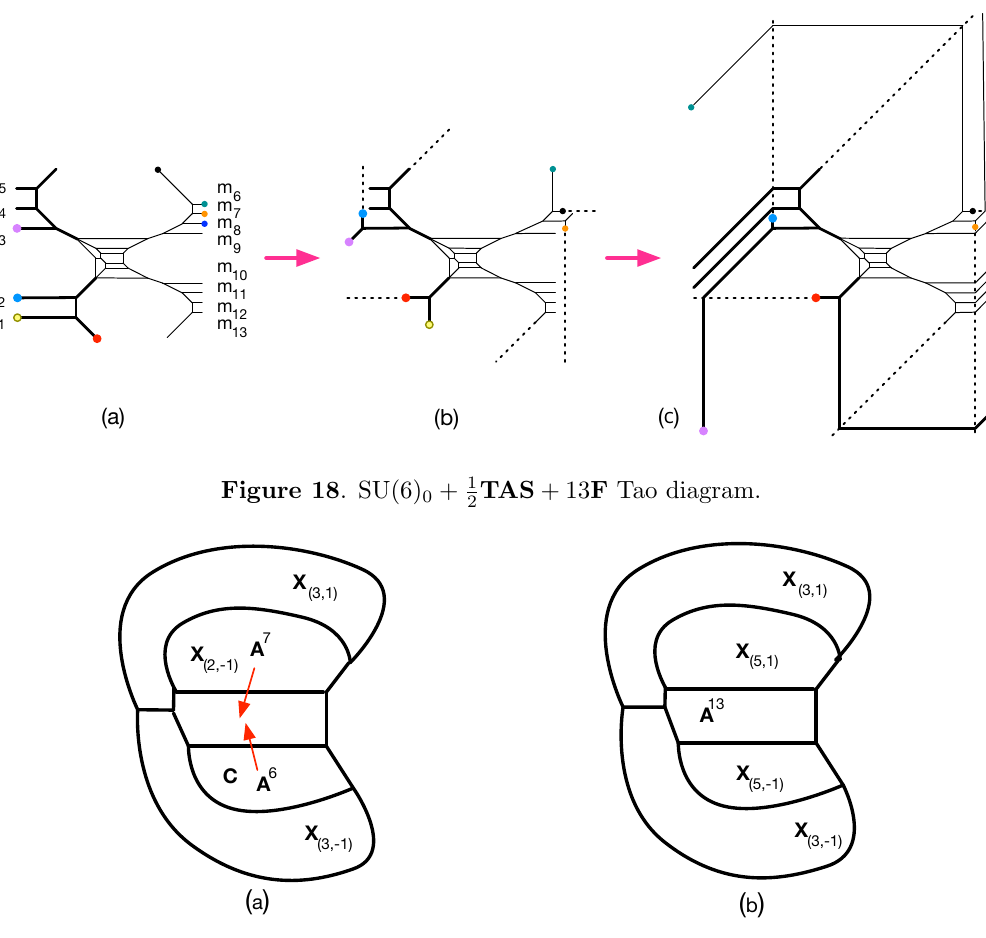
Figure 19 . (a) A 7-brane con(cid:12)guration of a web diagram for the SU(6) 0 + 1 (b) A 7-brane con(cid:12)guration showing SU(13) as the non-abelian part of global